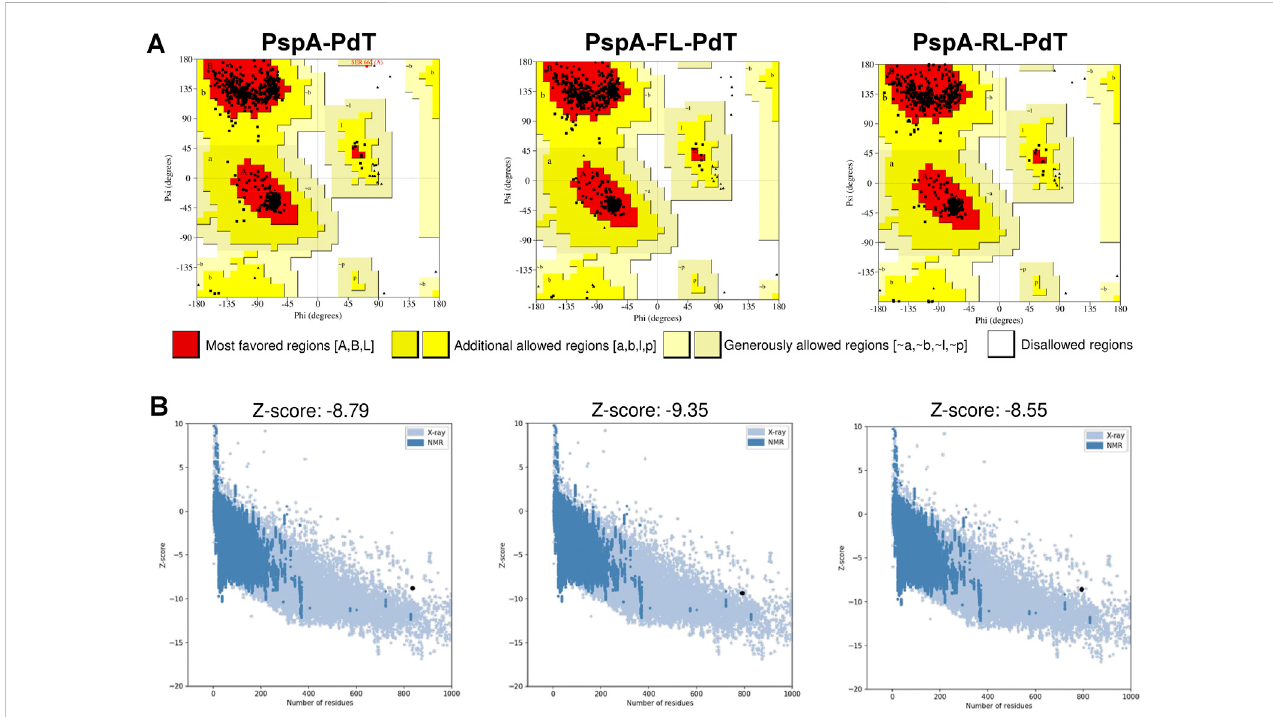
Overall model qualityevaluationby PROCHECK and ProSA-web ofthethree hybrids. (A) Ramachandranplots displaythepercentageofresiduesinmost favored(red),allowed (yellow) anddisallowed (white)regions;respectively, for PspA-PdT:95.7,4.2% and0.1%;for PspA-FL-PdT:96.4,3.6%and0%; forPspA- RL-PdT: 95.5,4.5% and 0%. Glycine residues are not counted inallowedor disallowed regions inRamachandran plot, thus non-glycine residuesare shown as black squares, and glycine residues are shown as black triangles. (B) Estimation of total quality by Z-score, which should not be outside the range of solved protein structures, indicating possible errors in the structures. The Z-scores of fusion proteins are shown as black circles in the graphs. It is possible to observe PspA-PdT and PspA-RL-PdT slightly outside the range, while PspA-FL-PdT falls within the area of solved structures